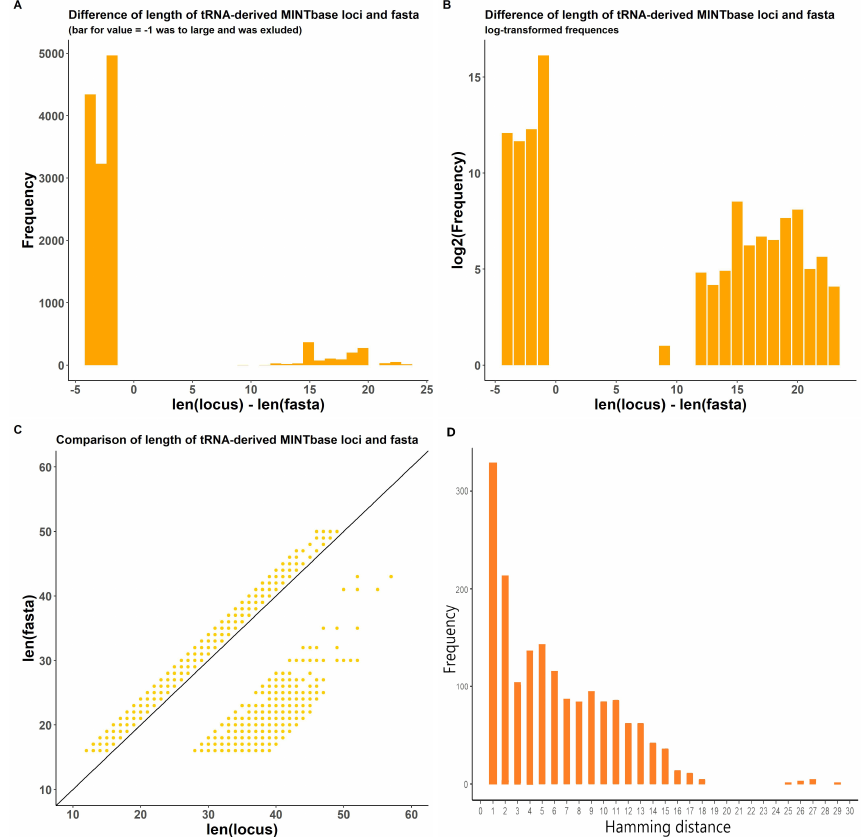
Figure 3. Statistics for database-delivered sequence ( fasta ) and genome locus-delivered sequence ( getfasta ) for MintBase transcripts. ( A ) Difference in lengths between fasta and getfasta in absolute values of frequency. Bar for value = − 1 was larger than others and was excluded for visualization. ( B ) Difference in lengths between fasta and getfasta in log-transformed values of frequency. ( C ) Plot for lengths of fasta and getfasta for transcripts. ( D ) Hamming distance distribution for transcripts where fasta and getfasta sequences have